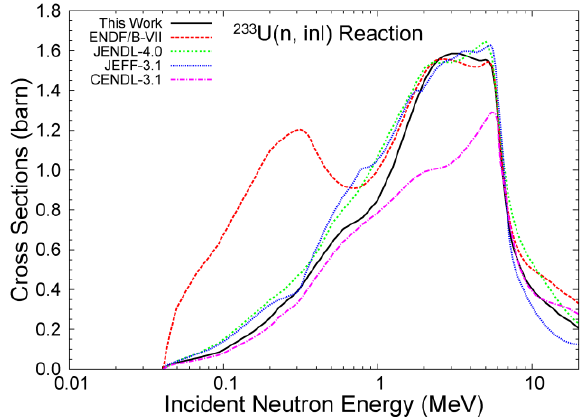
Fig. 15 . The modification for 233 U(n,inl) cross sections in CENDL-3.2, and the comparison to other evaluated